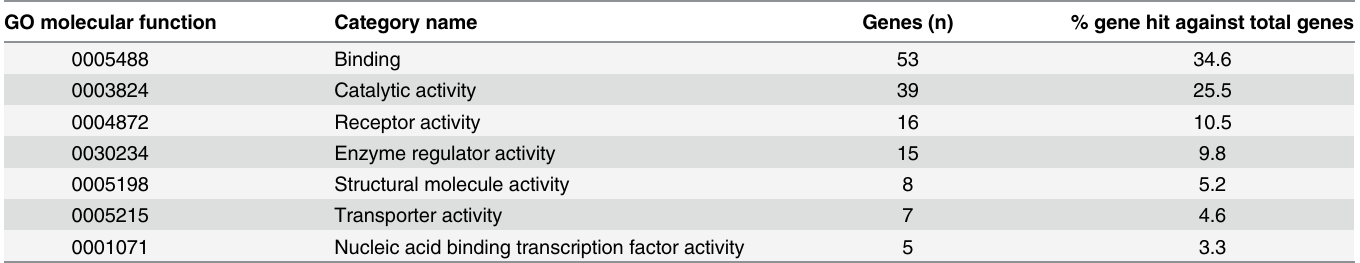
Table 2. Gene-ontology molecular-function categories upregulated in infected cystic-fibrosis cells compared to CTRL cells. GO molecular function